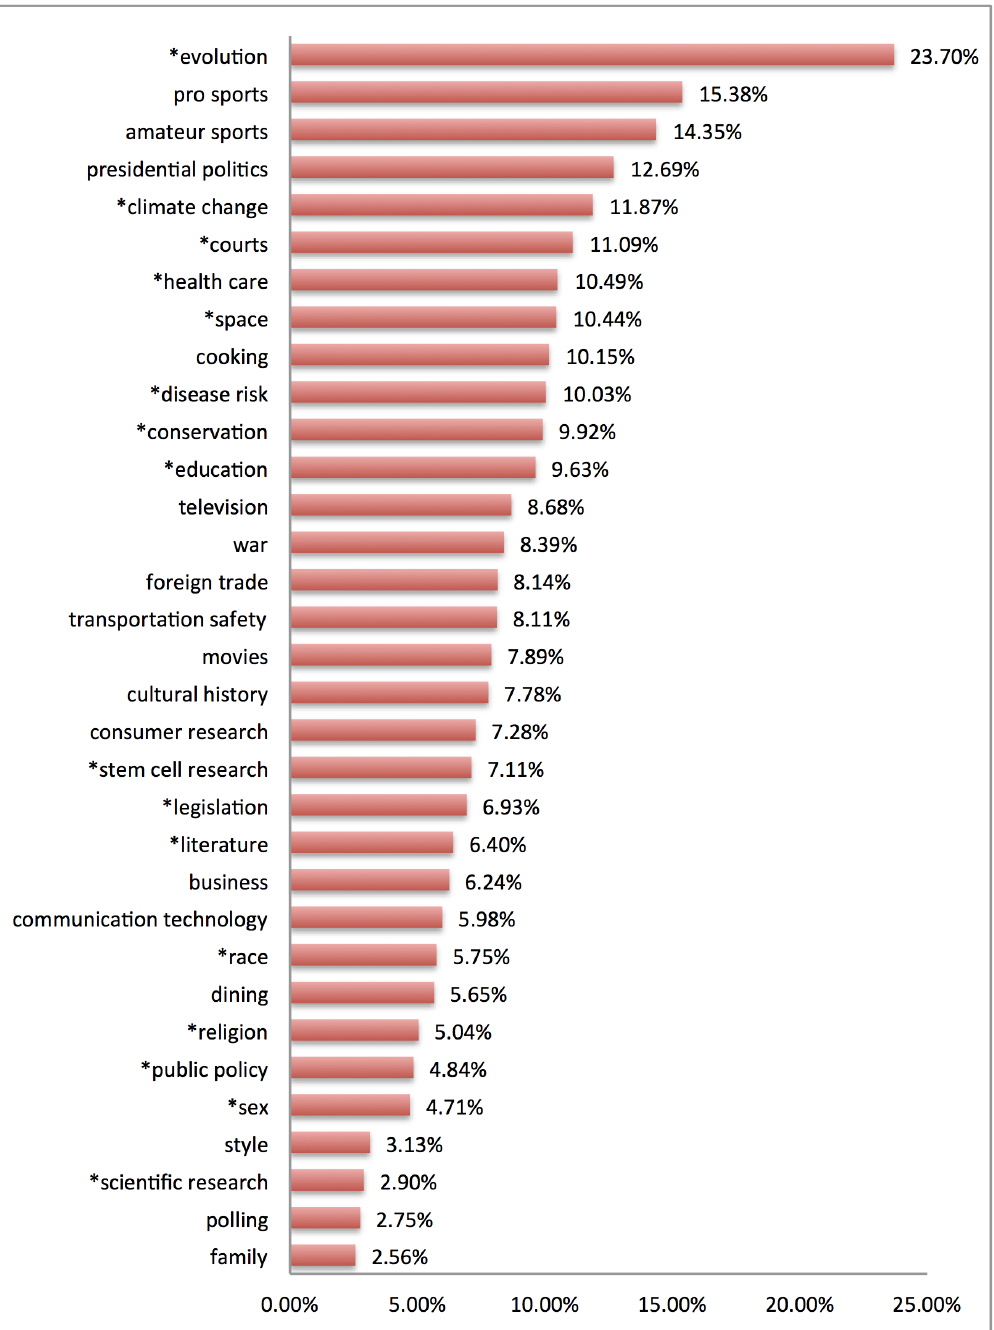
Figure 5. Labeled substantive topics ordered by rank_1 metric. The rank_1 metric measures the number of times a topic is the primary topic in the documents in which it occurs, here expressed as a percentage. Asterisks indicate subjects previously identified in qualitative case studies of demarcation. ( disease risk ). Illustrative examples of demarcation language from documents with high proportions of these topics include: